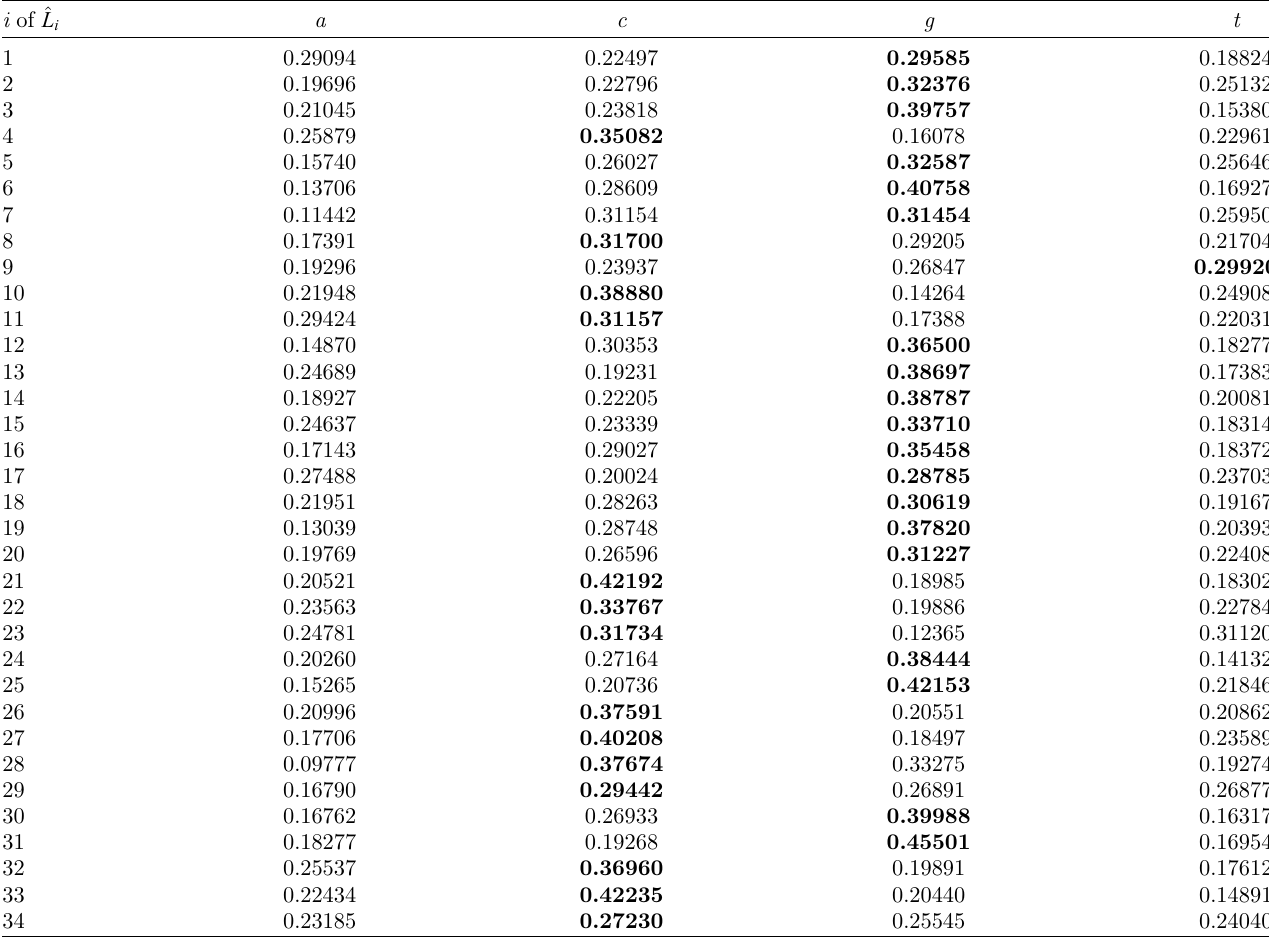
Table 4. Estimation of P ( (cid:5) | L letter the highest probabilities by